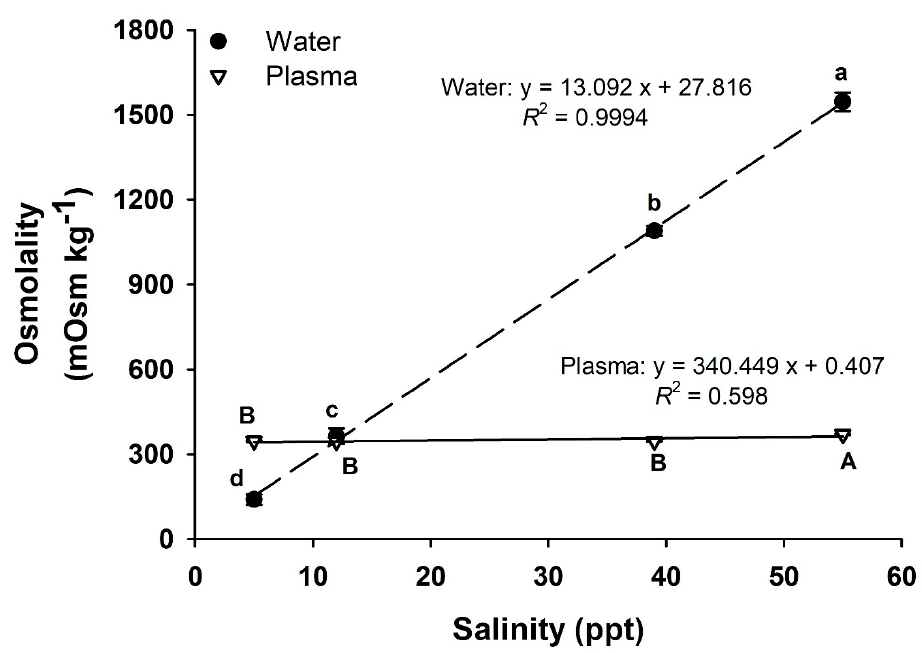
Figure 1. Water and plasma osmolality in Argyrosomus regius juveniles acclimated to different environmental salinities (5, 12, 39, and 55 ppt) for 21 days. Results are expressed as the mean ± standard error of the mean (SEM) ( n = 3 water samples per group; and n = 8–10 plasma samples per group). Different letters indicate significantly different groups for both water (lowercase letters) and plasma (capital letters) groups ( p < 0.05, one-way analysis of variance or ANOVA followed by Tukey’s post-hoc test).